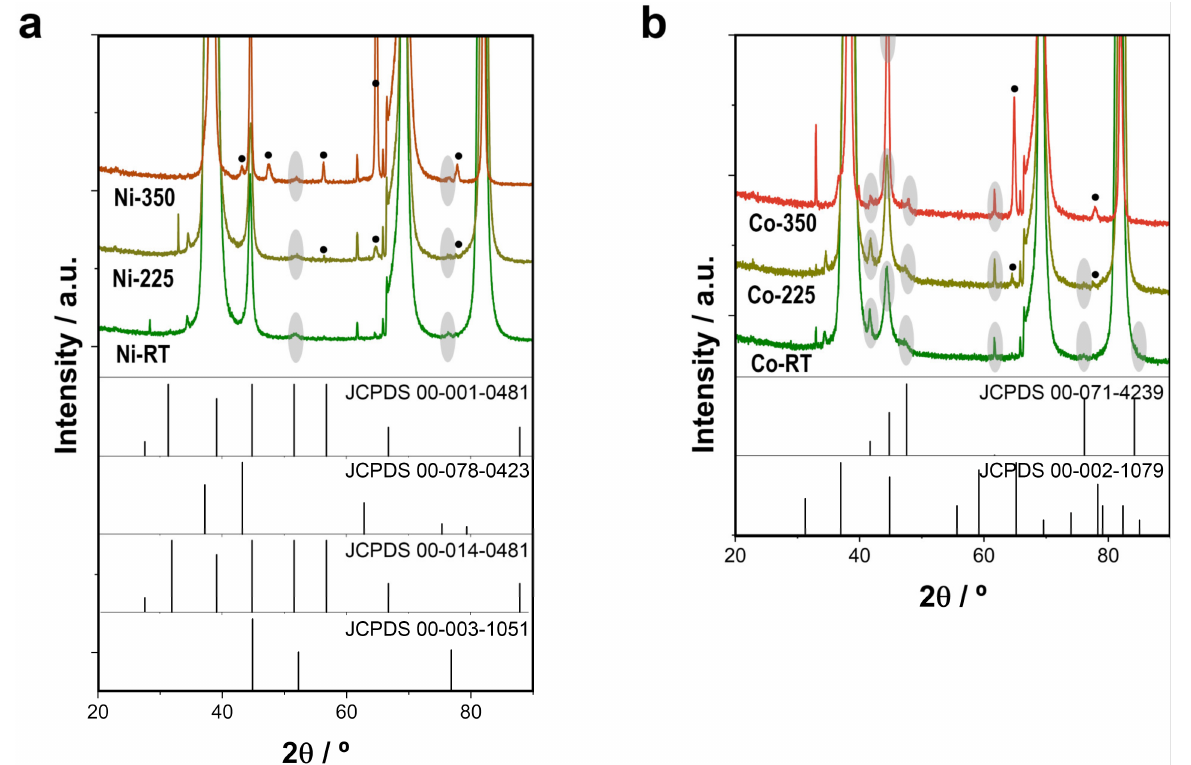
Figure 3. XRD patterns of electrodeposited ( a ) Ni-CoNi and ( b ) Co-CoNi deposits as prepared, after thermal annealing treatment at 225 ◦ C for 2 h, and after thermal annealing treatment at 350 ◦ C for 2